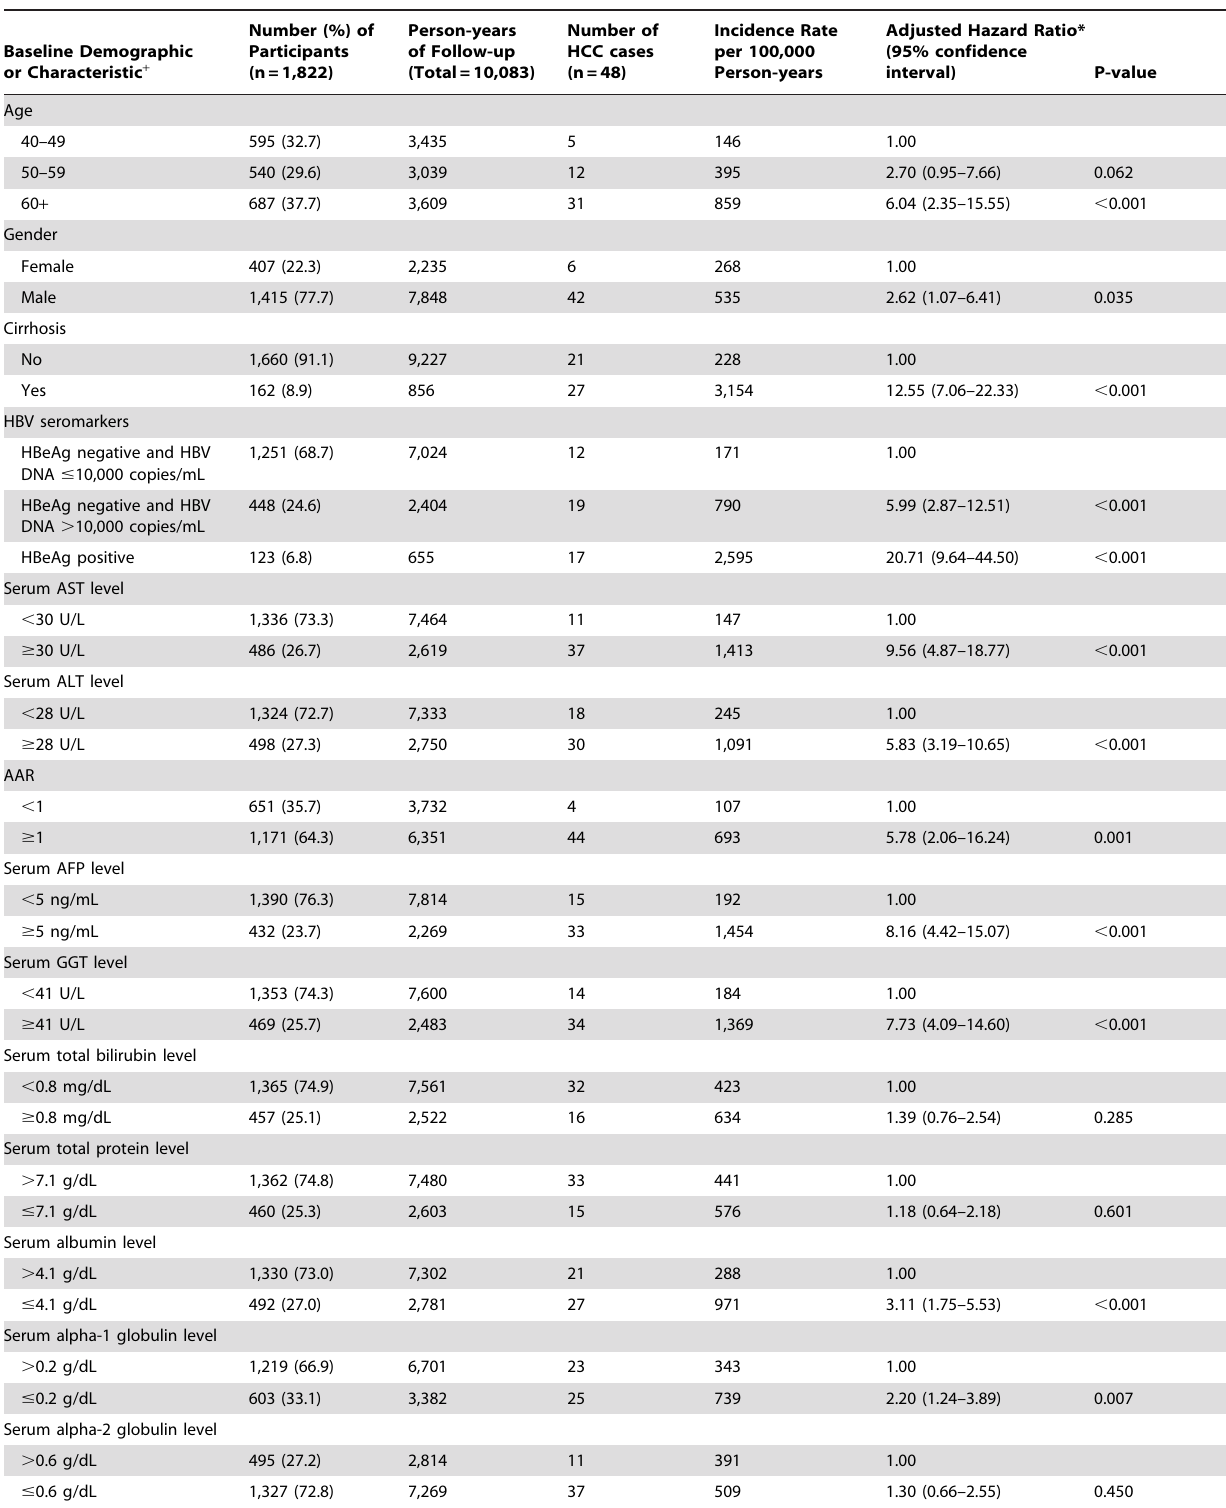
Table 1. Incidence Rates and Adjusted Hazard Ratios of Developing Hepatocellular Carcinoma (HCC) by Risk Predictors in 1,822 Anti-HCV-Seronegative Chronic HBV